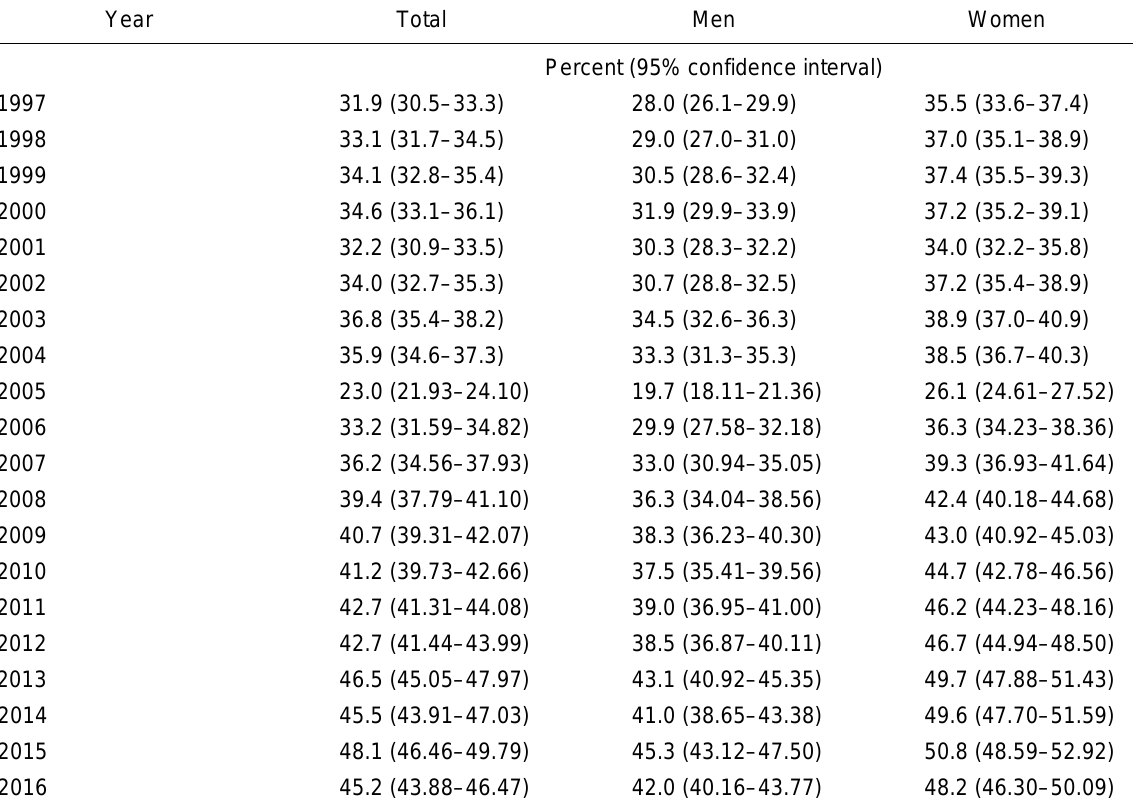
Table 4.1a. Percentage of adults aged 50–64 who received an influenza vaccination during the past 12 months, by sex: United States,